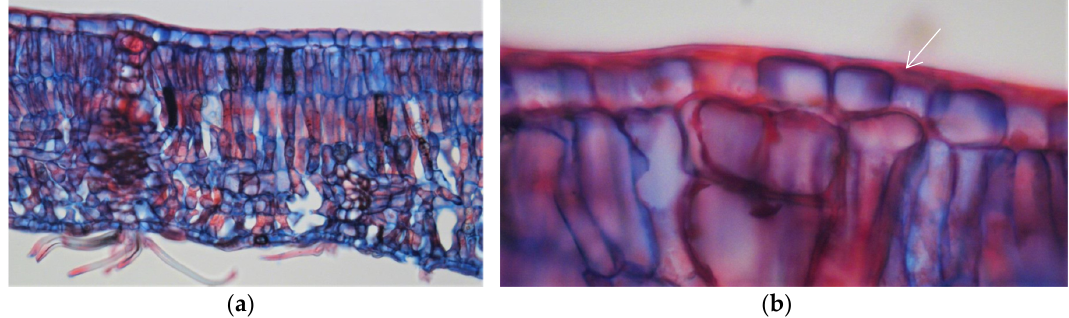
Figure 2. Optical microscopy photographs of a cross-section of a Quercus suber leaf ( a ) and an enlargement of the adaxial side showing the cuticular membrane ( b ). Arrows indicate the cuticular structures covering the epidermal cell layer.